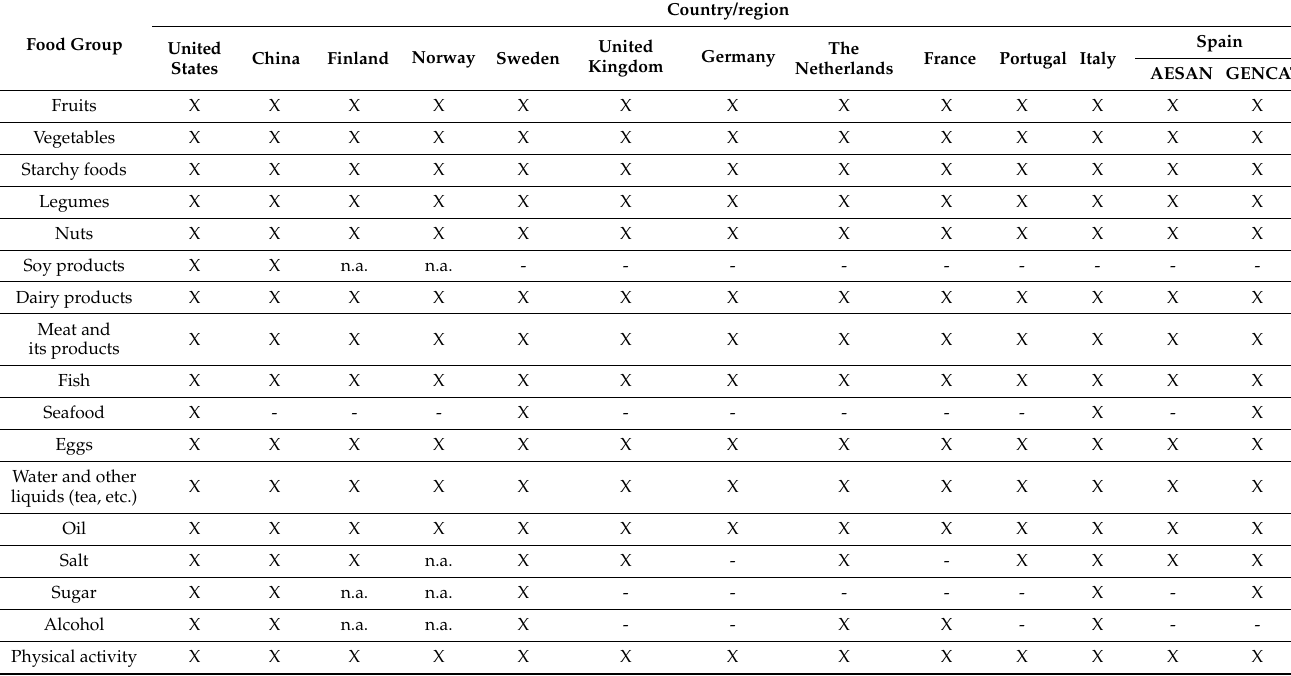
Table 3. Food groups and other important categories for which the international food guides have established dietary